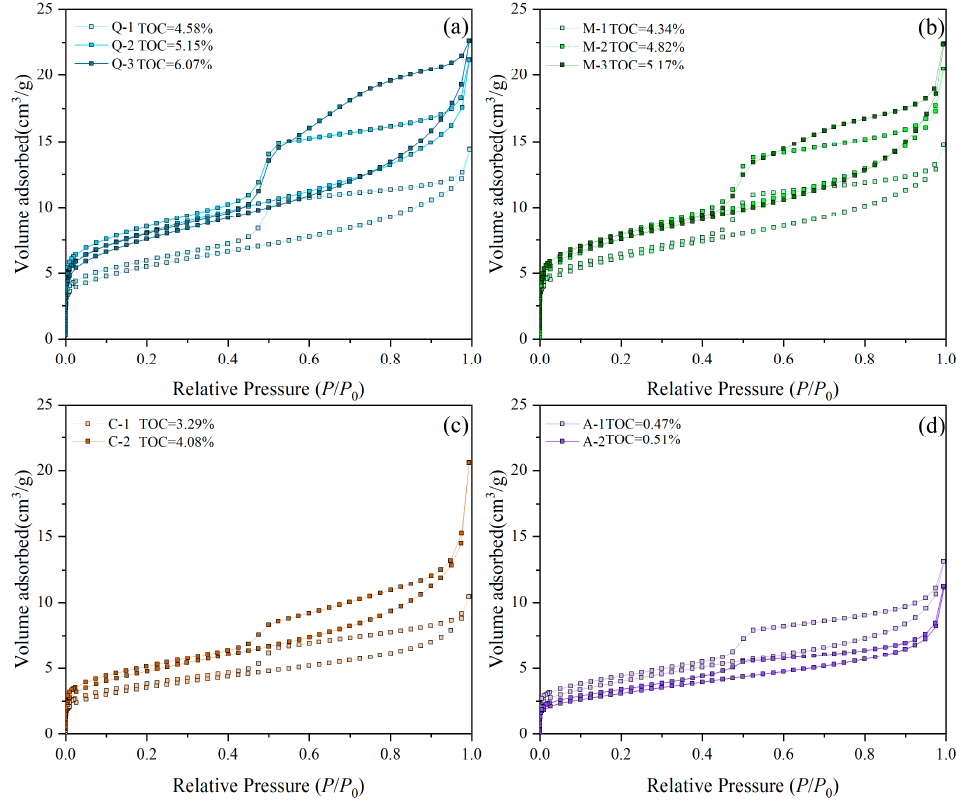
Figure 3. Nitrogen adsorption and desorption isotherms for the Longmaxi shale samples in the Changning block, Sichuan Basin. ( a ) Siliceous shale; ( b ) Mixed shale; ( c ) Calcareous shale; ( d ) Argillaceous shale